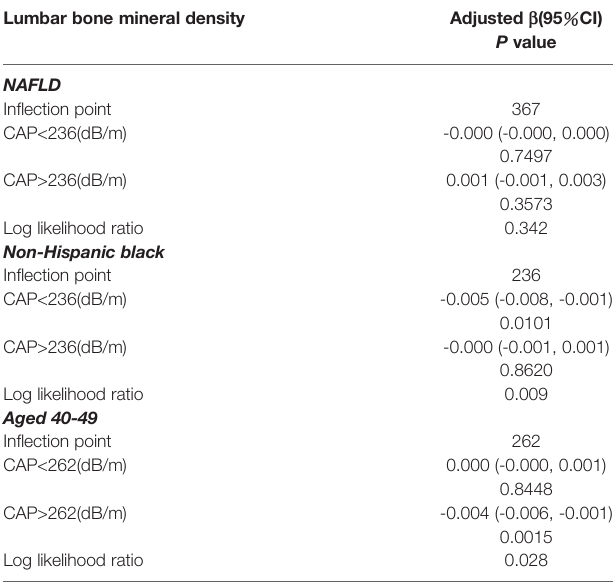
Age, gender, race, body mass index, poverty to income ratio, education, smoking behavior, Moderate activities, Diabetes status, Waist circumference, HbA1c (%), Total cholesterol,Triglyceride,LDL-cholesterol,HDL-cholesterol,ALT,ALP,GGT,AST,Serum creatinine, Serum iron, Lumbar bone mineral density, CAP and LSM were